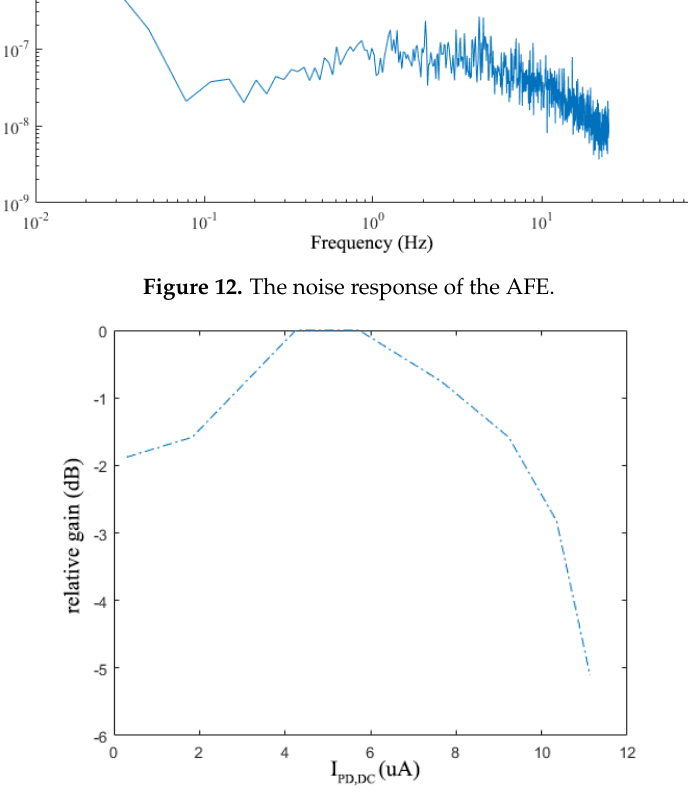
Figure 13. The transimpedance gain (in dB), relative to the nominal value of 142 dB Ω , at different DC